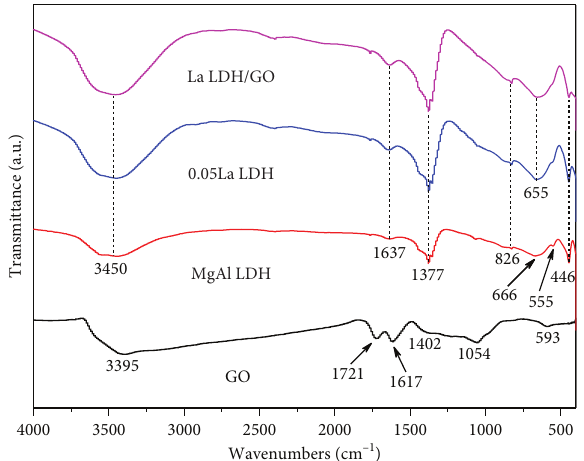
Figure 3: FTIR spectra of GO, MgAl LDH, 0.05 La LDH and La